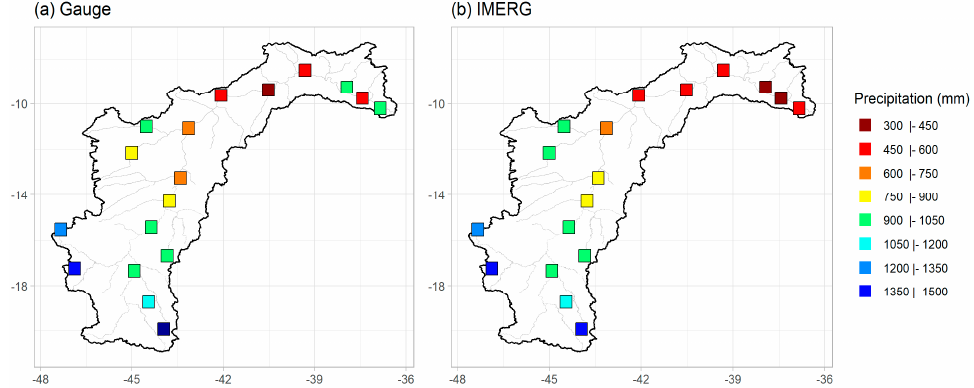
Figure 2. Spatial distributions of mean annual precipitation (2000 to 2019): ( a ) Rain gauges, ( b ) IMERG.